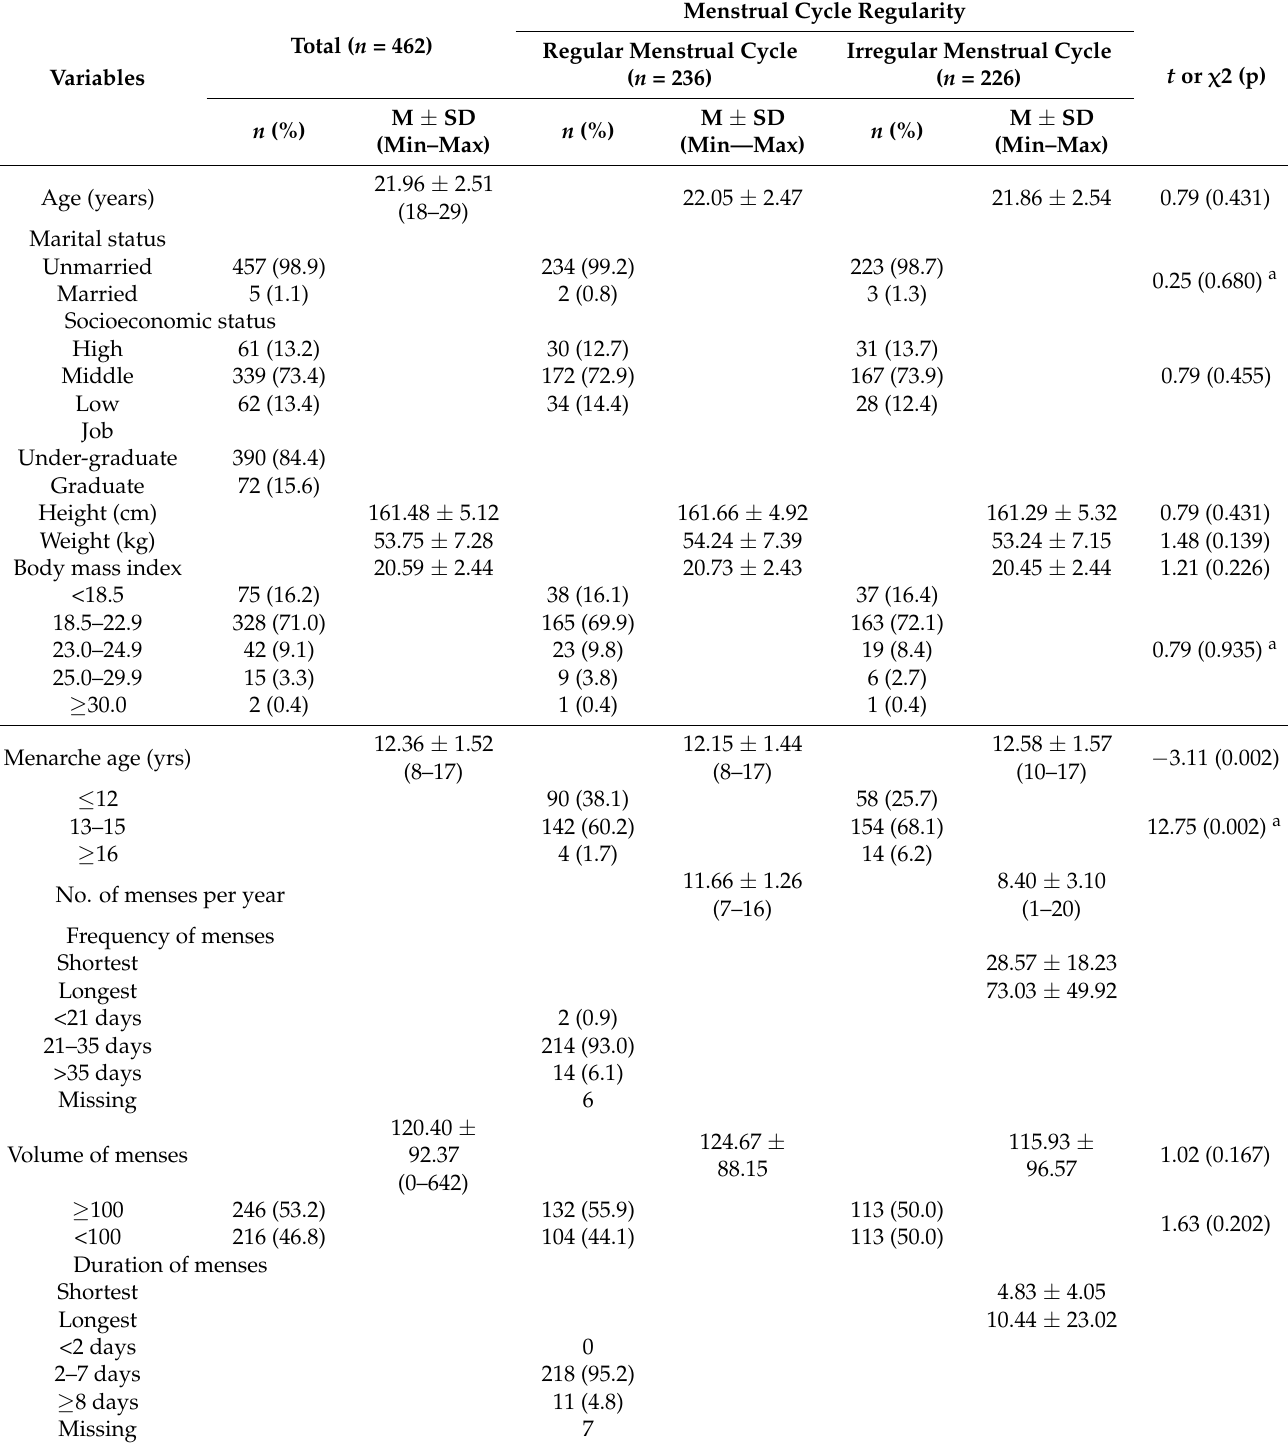
Table 1. General characteristics, menarche age & menstrual cycle patterns according to menstrual cycle regularity ( n = 462).